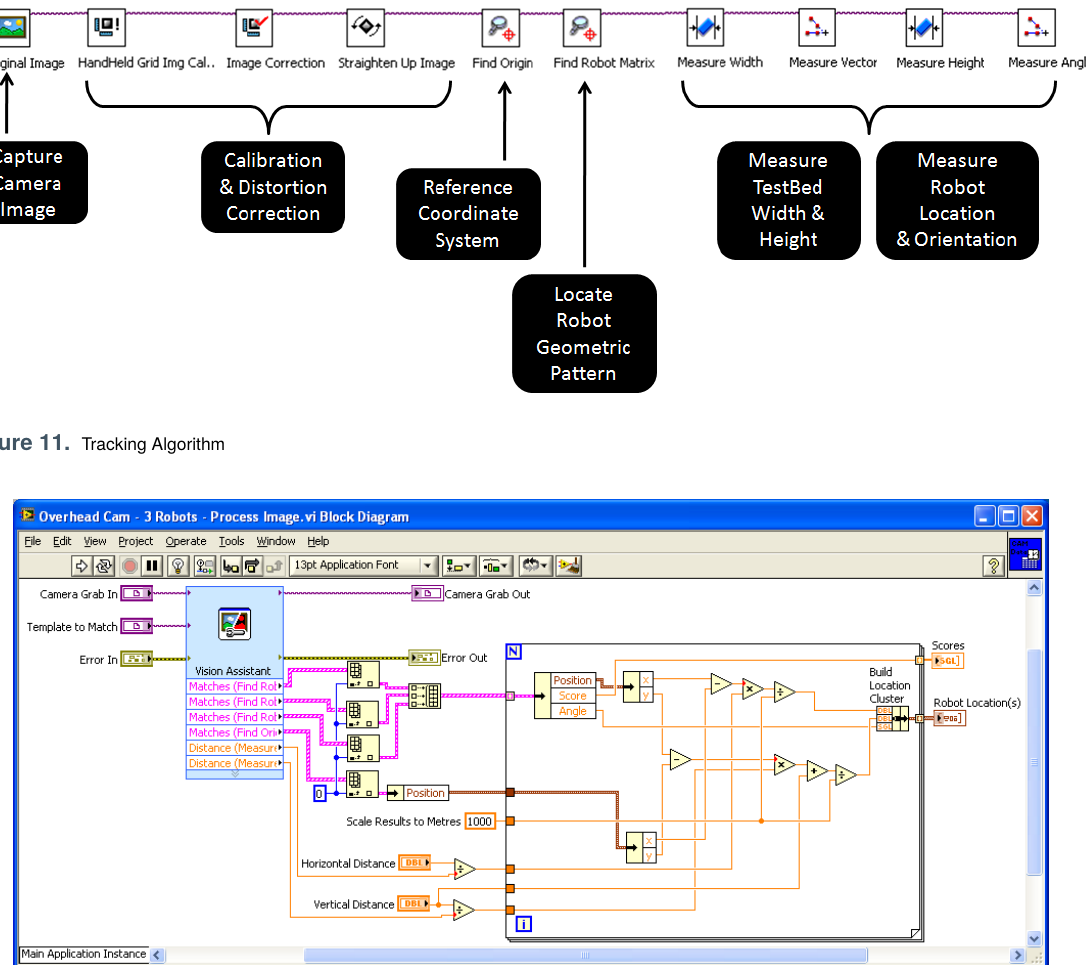
Figure 12. LabVIEW VI Implementation of the Video Tracking System